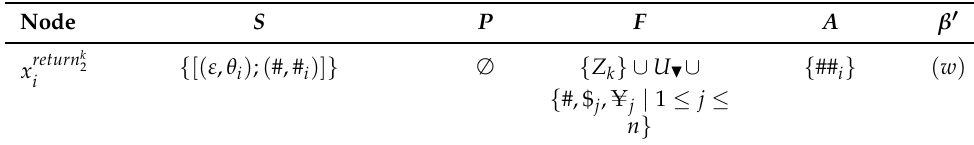
Table 3. Description of the returning